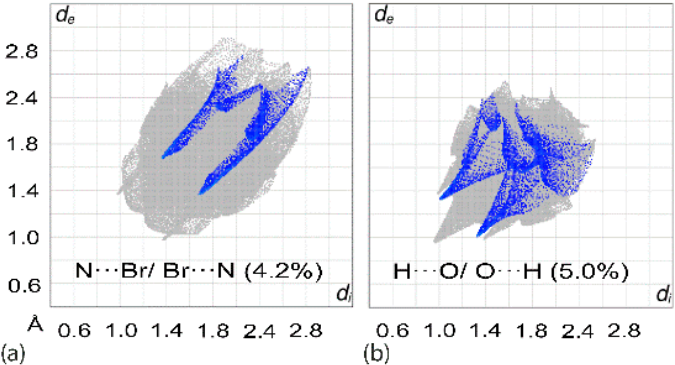
Figure 7. Fingerprint plots decomposed into ( a ) N···Br/Br···N for 1b and ( b ) H···O/O···H for 1c .